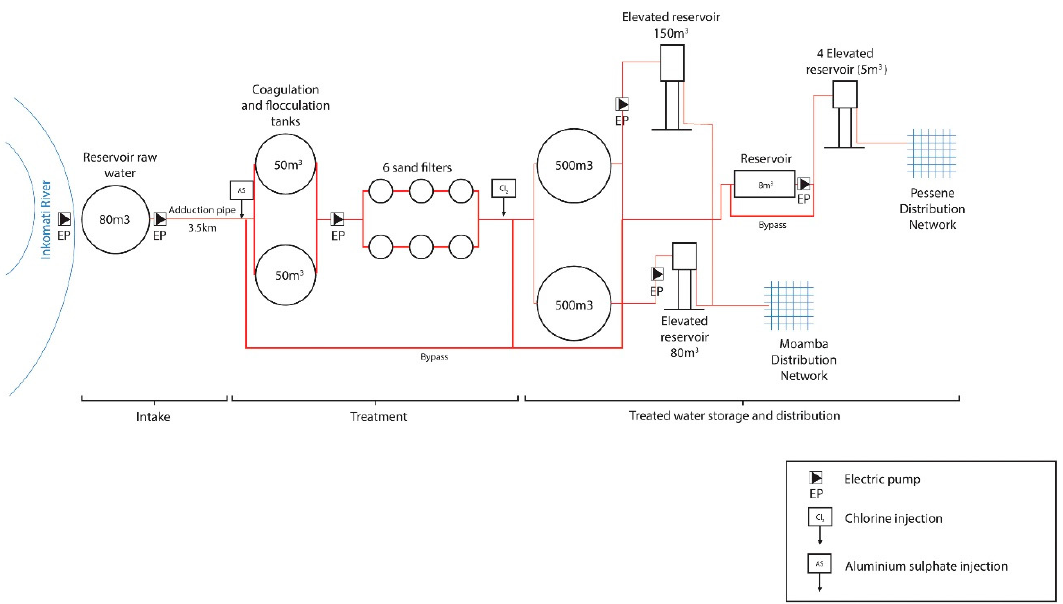
Figure 1. Moamba’s Water Supply System Scheme. (Source: Collins Sistemas de Agua Lda.).